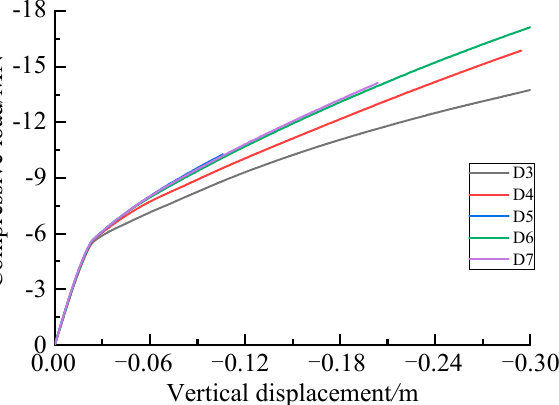
Figure 21. Compressive load-displacement curves of helical pile with various diameters.